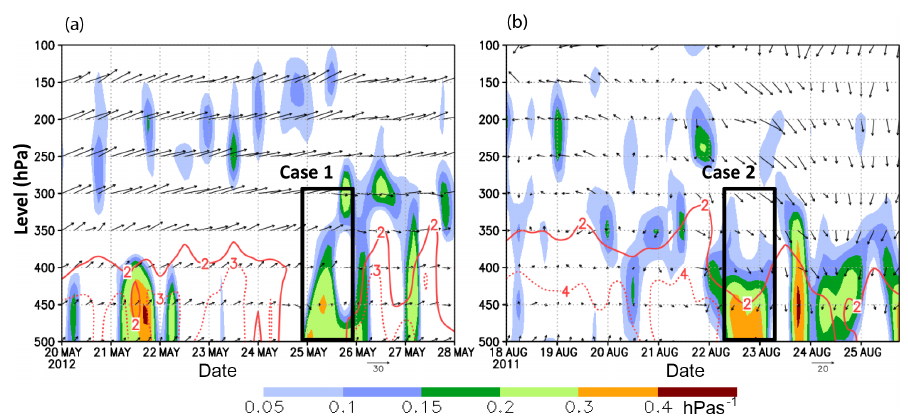
Figure 7. Vertical velocity in pressure coordinates, ω , (shaded), specific humidity (red lines) and horizontal wind field (arrows) in dependence of time and height in two time frames. (a) From 20 to 28 May 2012; (b) From 18 to 25 August 2011. Case 1 and Case 2 correspond to two significant downdraft events.